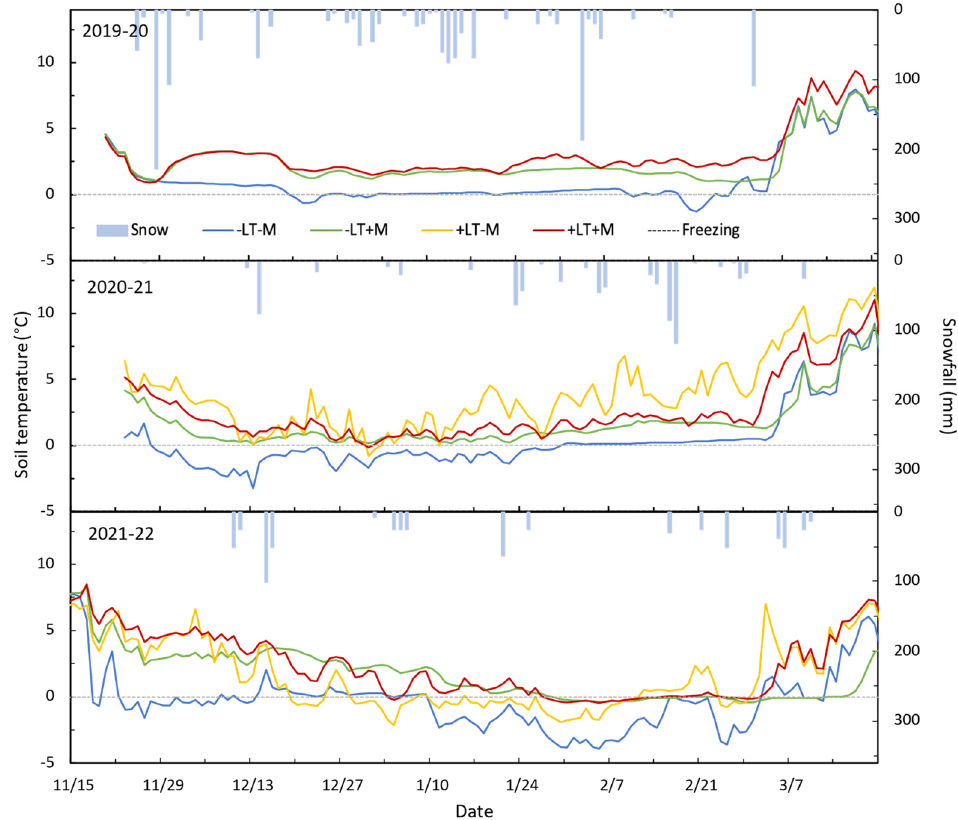
Figure 2. Average daily snowfall (light blue bars) [42] and soil temperature (0.05 m depth) during the winter of 2019 − 20 ( top ), 2020 − 21 ( middle ), and 2021 − 22 ( bottom ) under no cover (-LT-M; blue line), mulch (-LT+M; green line), a fabric low tunnel (+LT-M; yellow line), and mulch and a fabric low tunnel (+LT+M; red line) in the field in North Logan, UT.